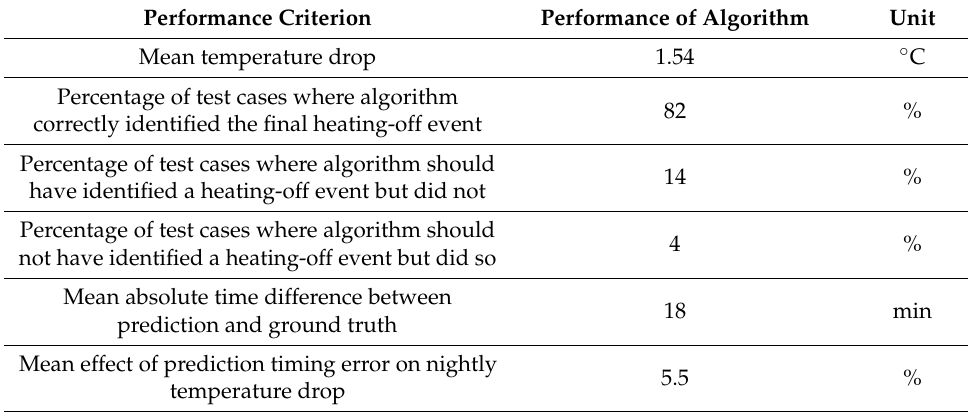
Table 1. Algorithm